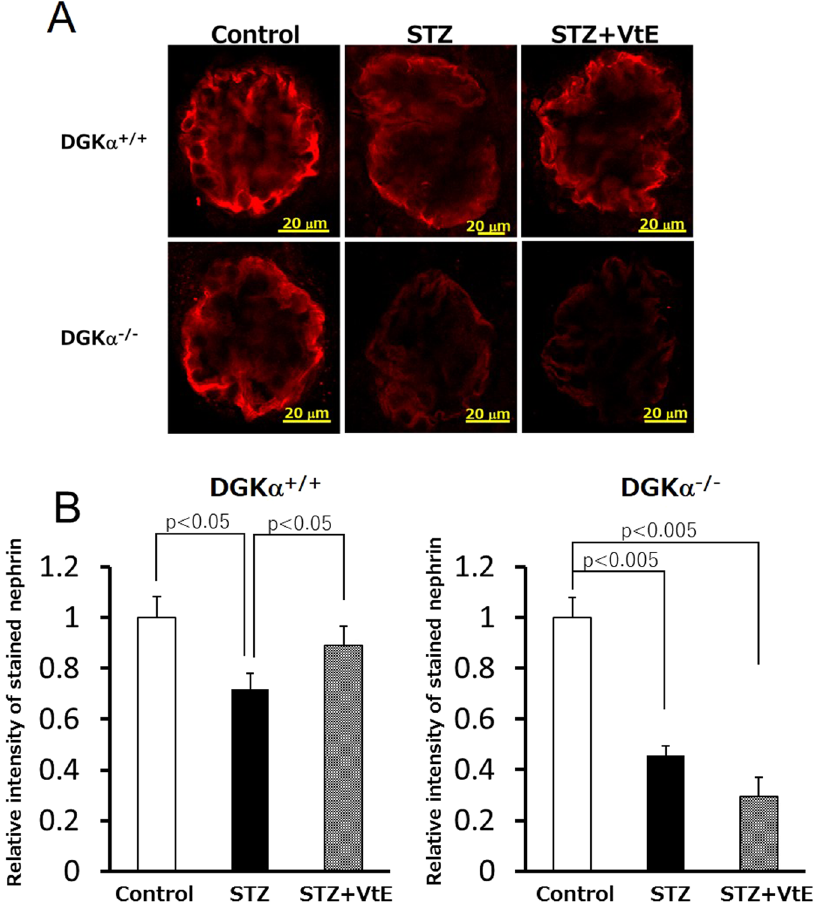
Figure 4. Evaluation of podocyte loss by immunofluorescent staining of nephrin. The kidneys of mice were removed at 6 weeks after STZ administration and were sectioned. We performed immunofluorescent